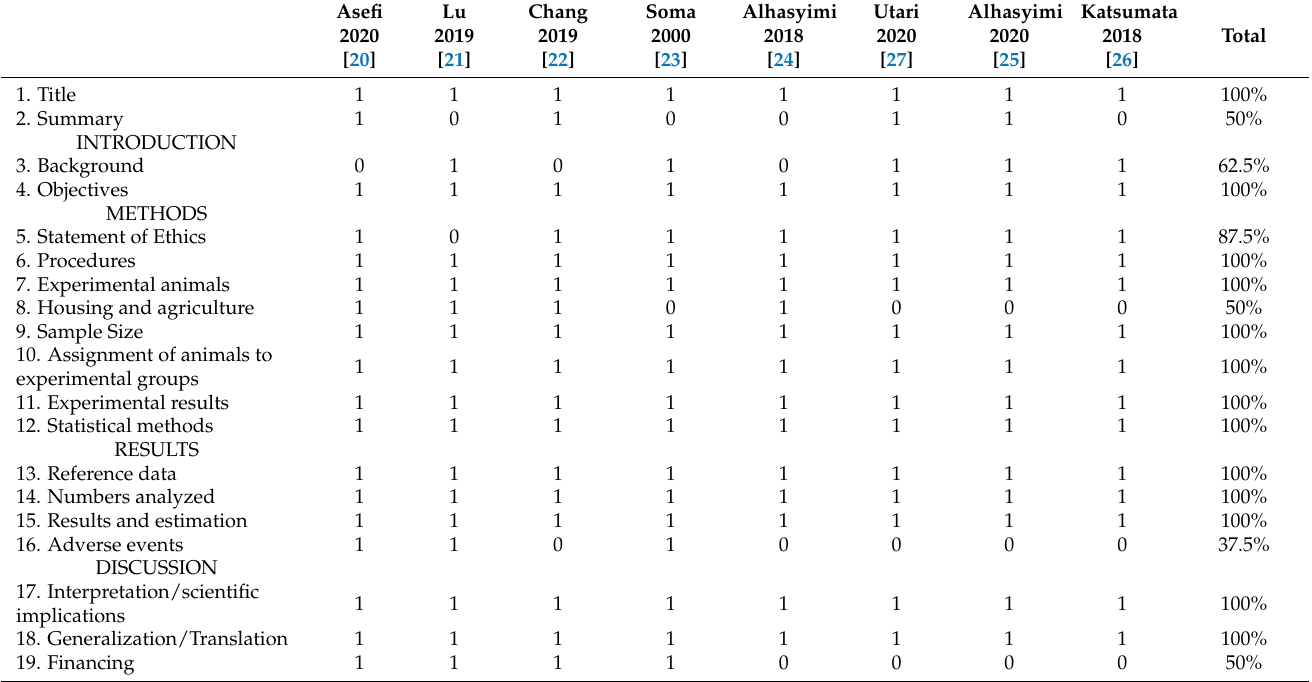
Table 4. Quality assessment of included studies. ARRIVE criteria.